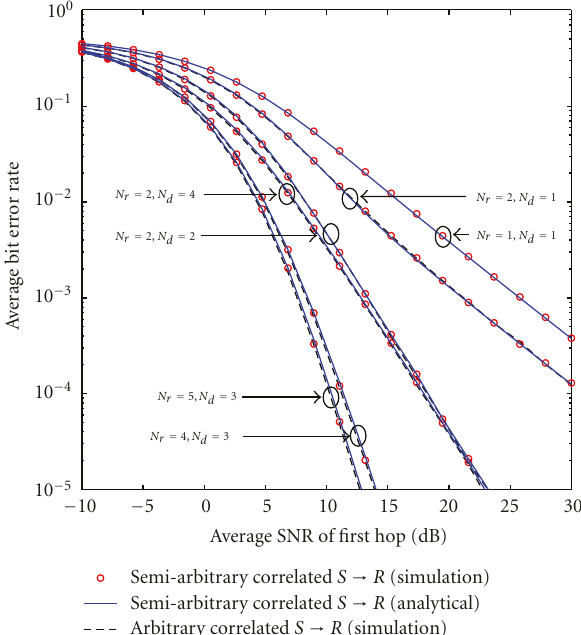
Figure 2: Average BER of BPSK for dual-hop MIMO relaying with antenna correlation at the relay and destination. γ l d = 0 . 5, θ s = θ d = 3 π/ 2, and σ 2 and N r = 5, ρ is chosen as [0 . 5,0 . 55], [0 . 45,0 . 55,0 . 50,0 . 60], and